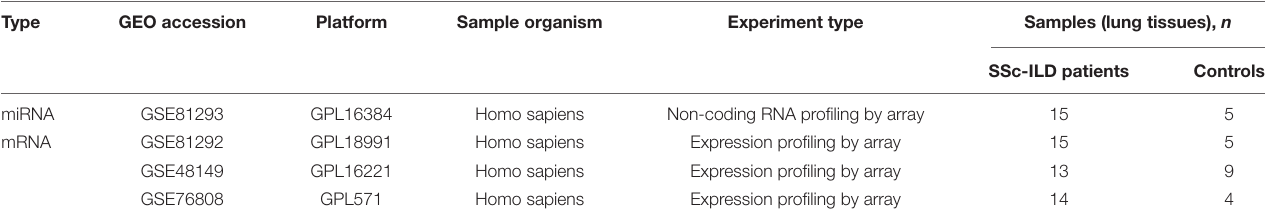
TABLE 1 | Details of miRNA and mRNA datasets of patients with SSc-ILD.